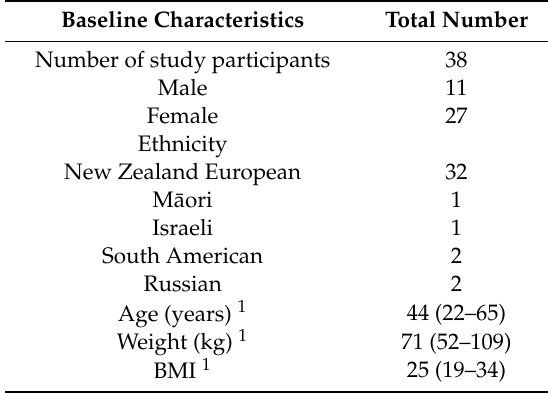
Table 2. Demographics and baseline characteristics of participants in this study.